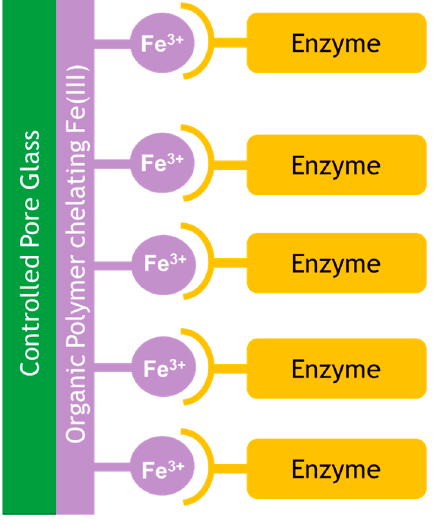
Figure 4. EziG binding of enzyme via Fe(III) coated to an organic polymer coated on controlled pore glass.